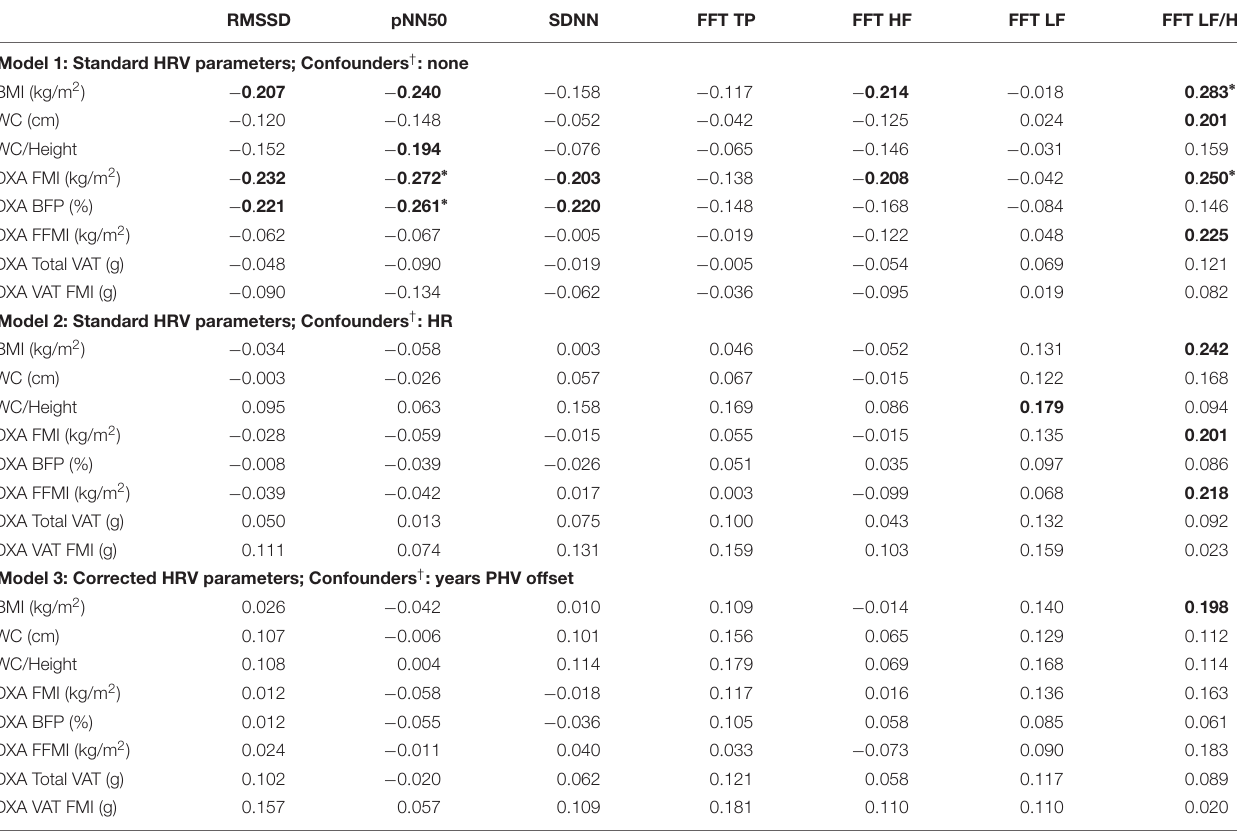
TABLE 3 | Standardized beta coefficients from linear regression models on the associations of body composition measures with standard and corrected HRV parameters. RMSSD pNN50 SDNN FFT TP FFT HF FFT LF FFT LF/HF